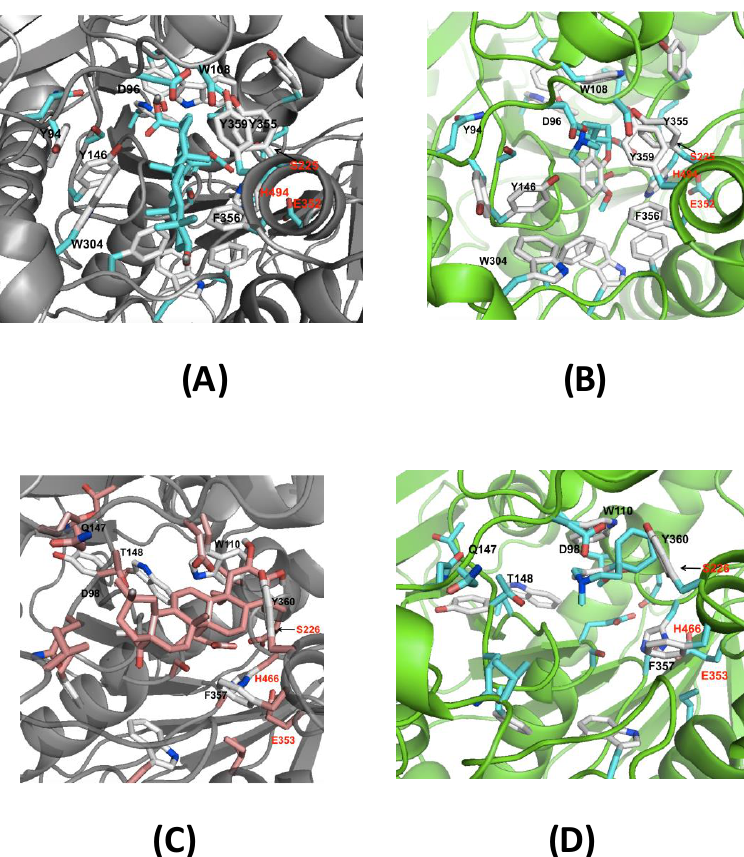
Figure 8. Docking results of betulinic acid ( A , central cyan moiety) and galantamine ( B , central cyan / white moiety) in the homology model of AChE; maslinic acid ( C , central salmon moiety) and galantamine ( D , central cyan / white moiety) in the homology model of BChE. Residues interacting with the ligands are indicated in black and the residues of the catalytic triad in red.